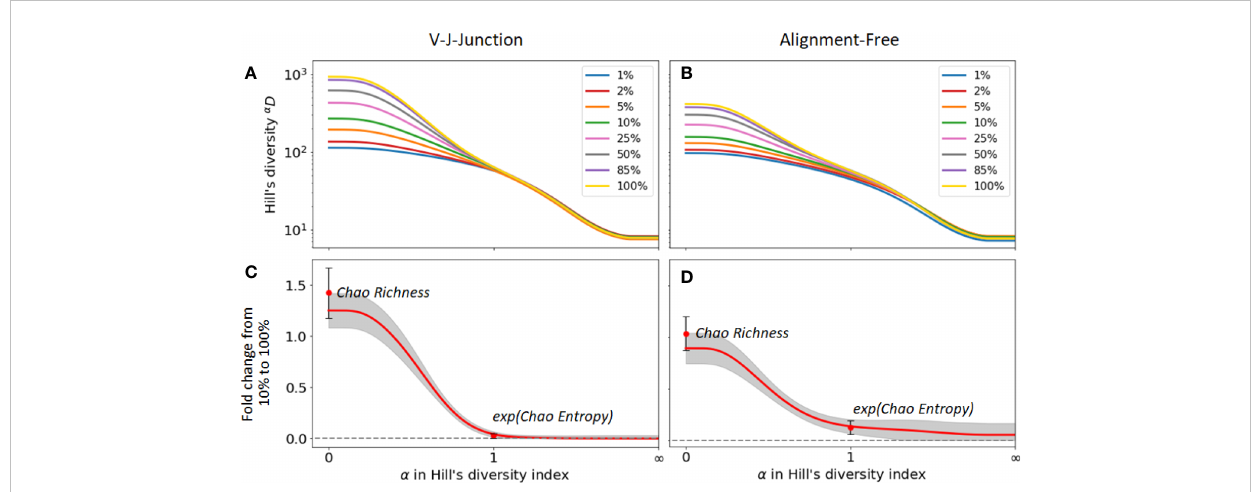
FIGURE 5 Sensitivity of diversity metrics to sequencing depth for the GC dataset. (A, B) Hill ’ s diversity pro fi le calculated at different sub-sampling ratios varying from 1% to 100%. (C, D) Fold changes between Hill ’ s diversity index computed respectively at 10% sub-sampling and 100% sampling. The mean (read line) and one standard deviation (grey shaded area) across the 100 sub-sampling repetitions are shown in both fi gures. Similarly, the mean and standard deviation of the Chao estimator for richness and entropy are